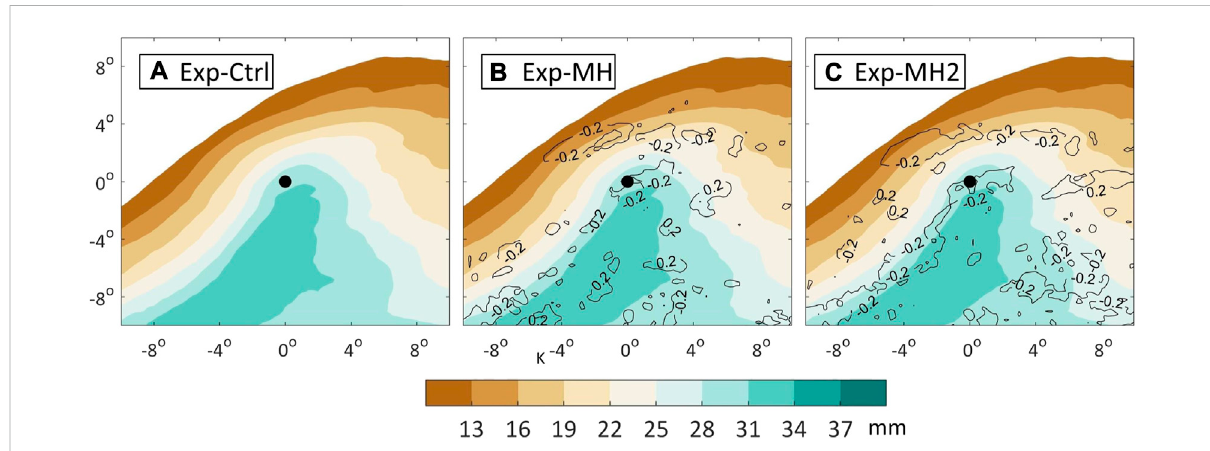
FIGURE 14 Precipitable water around cyclone centers for each modeling experiment. Contours in (B) / (C) denote the difference between Exp-MH/Exp- MH2 and Exp-Ctrl. Precipitable water is averaged among the four ECs during their fi rst 24